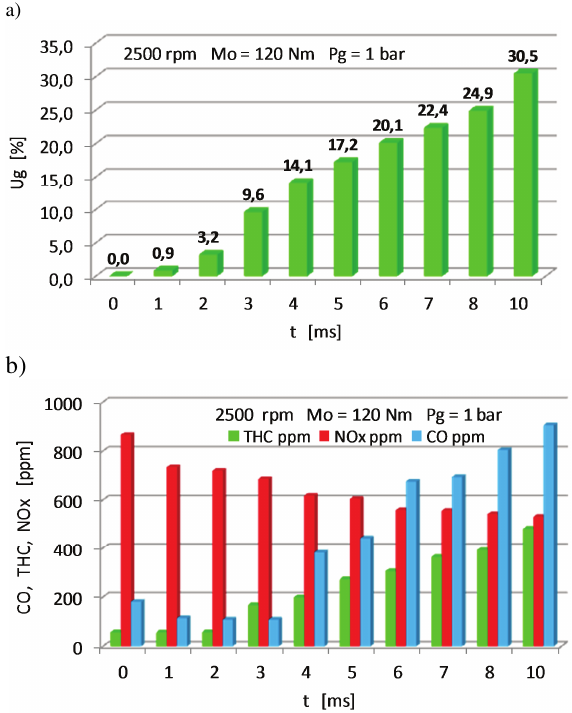
Fig. 6. Changes the gas energy share U g and the concentration toxic com- ponents of exhaust gases of engine Fiat 1.3 MTI depending on gas injec- tors opening time: fixed gas supply pressure 1 bar